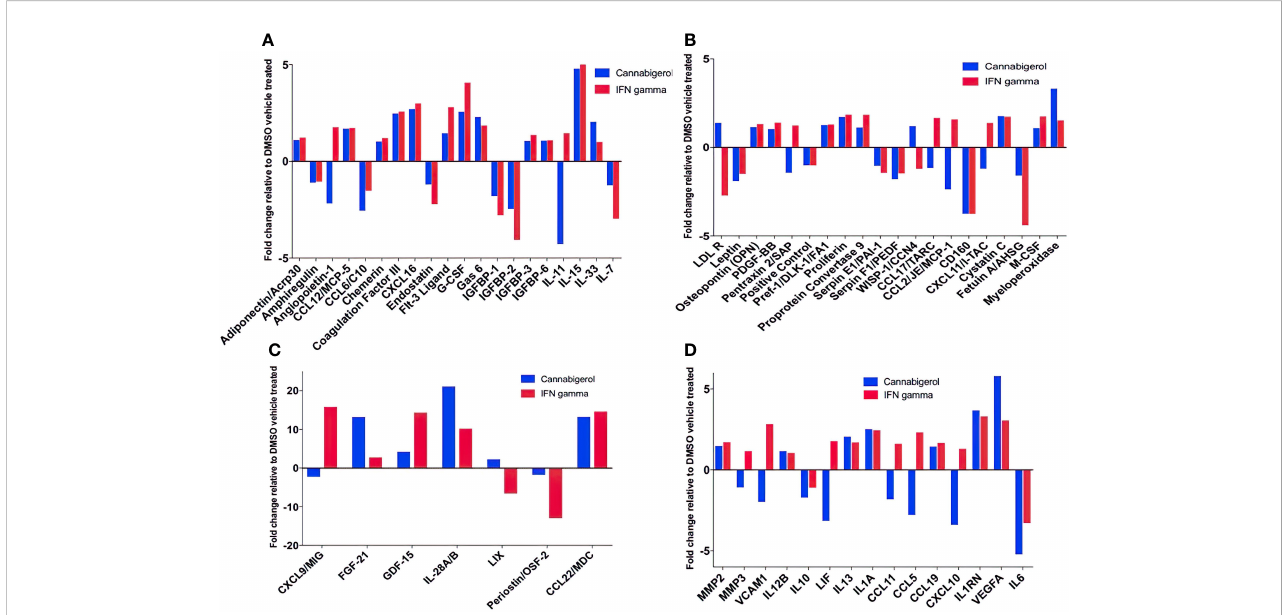
FIGURE 6 Fold change of cytokine production in Metastatic Carcinomas treated with cannabigerol or in supernatant upon treatment of 0.00875 mg/mL cannabigerol (0.05529 m mol) and 0.1ug/mL (100ng/mL) (5.832x10 -6 nmol) IFN- g relative to DMSO (vehicle)-treated metastatic A9 cells. (A – C) Fold change of cytokines present on microarray (D) Cytokines implicated in the IL4, 10, and 13 pathways. Data was determined using Proteome Pro fi ler Mouse XL cytokine array kit and Image J protein analyzer add-on. Pathway analysis was determined using Reactome Database release 65, Pathway Brower Version